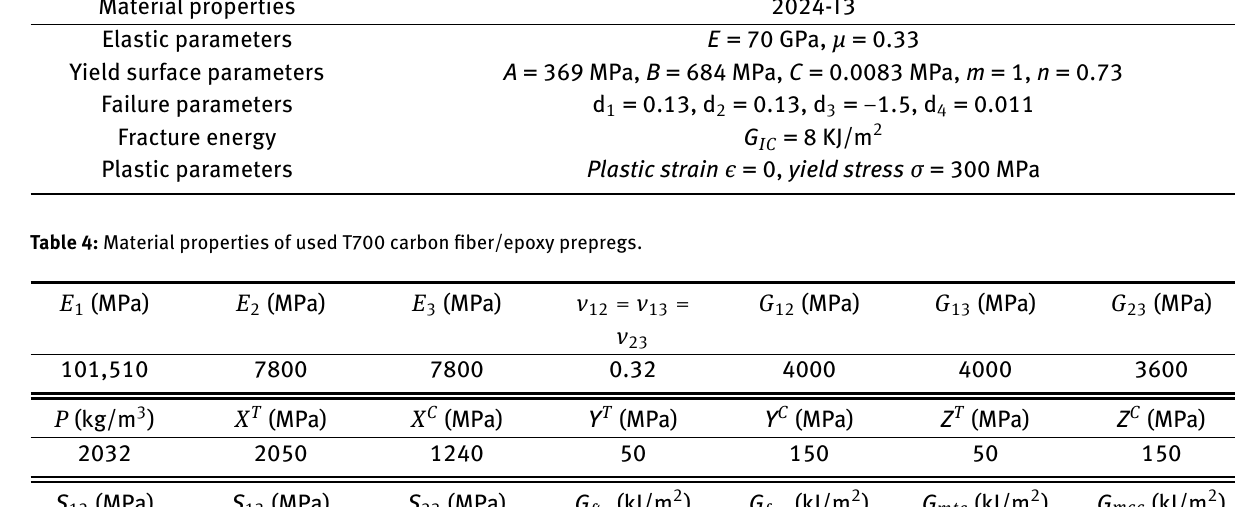
Table 3: Material properties of the aluminum alloy used. Material properties